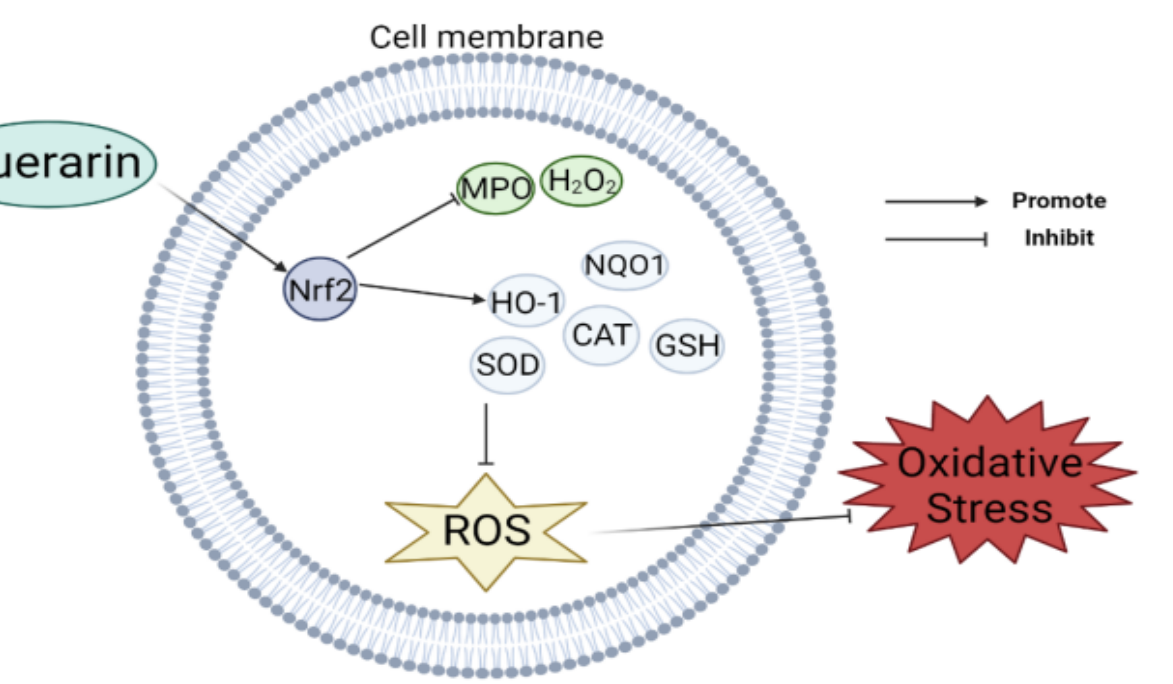
Figure 1. Partial mechanism of puerarin alleviating oxidative stress [9,11–13].